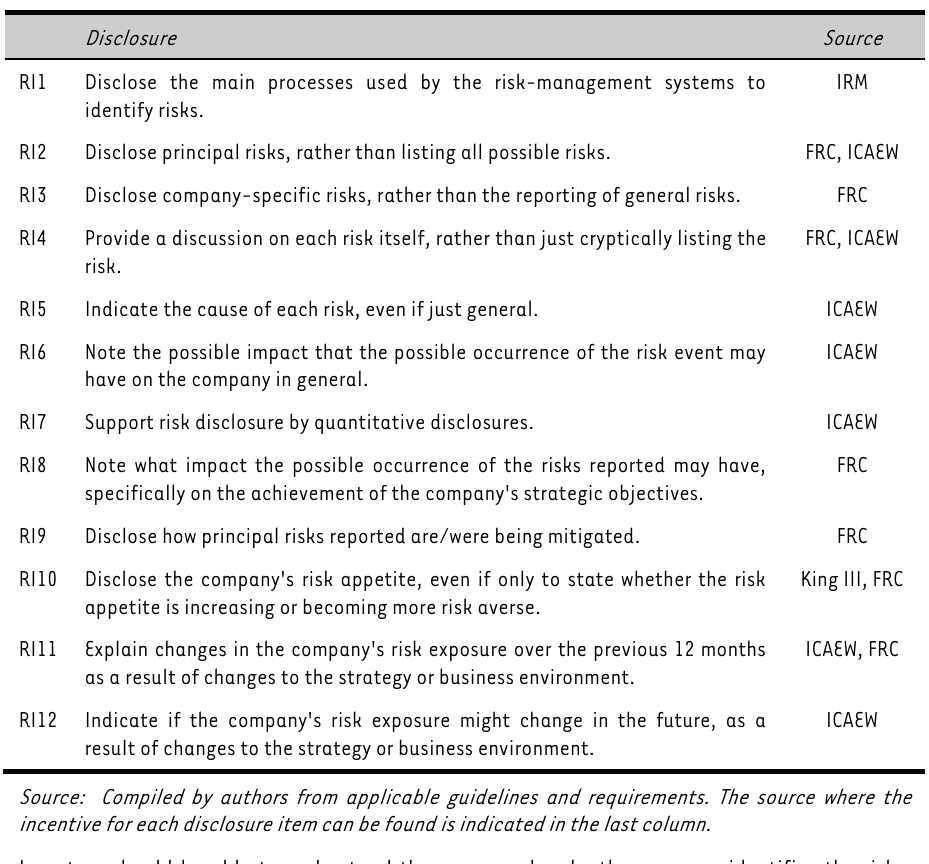
Risk-disclosure index for risks and risk identification Disclosure